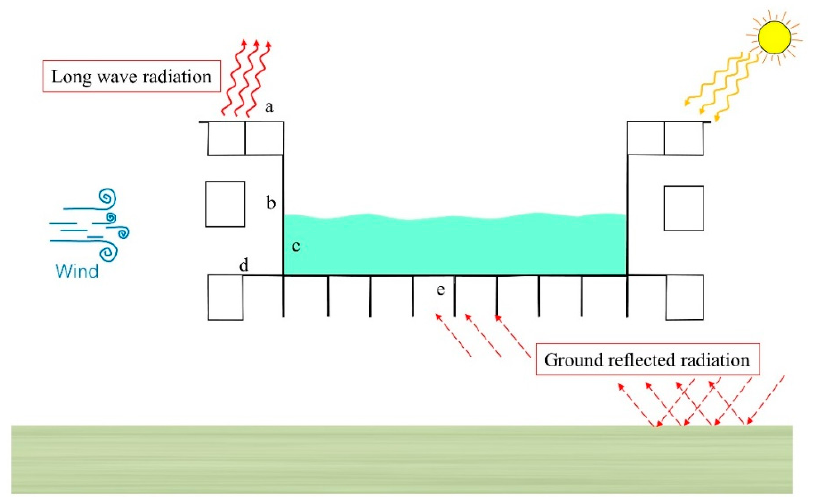
Figure 8. Thermal boundary condition on the FEM model.